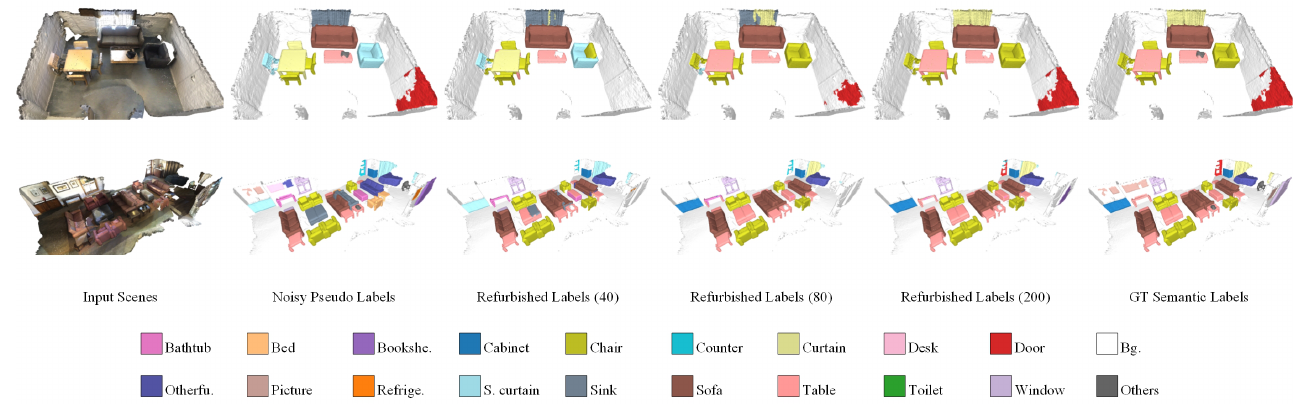
Figure 11. Qualitative demonstration of history-guided label refurbishment. From left to right are the input point clouds, the corresponding noisy pseudo-labels, the refurbished labels in epochs 40, 80, and 200, and the ground-truth semantic labels.